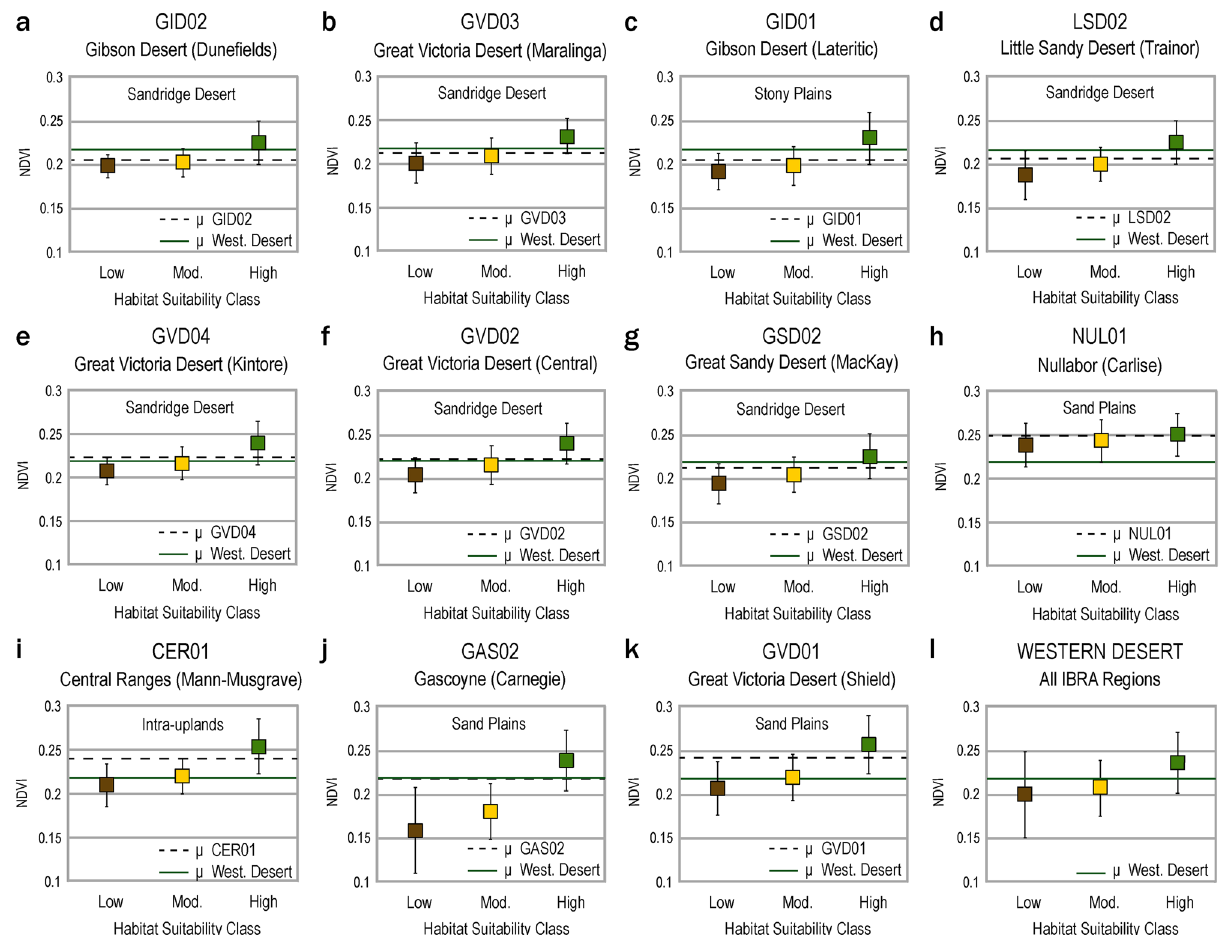
Figure 5. Boxplot of mean NDVI values and one standard deviation for low, moderate, and high-ranked suitability classes for the eleven largest IBRA subregions ( a – k ) of the Western Desert ( l ). Mean NDVI for individual bioregions and the spatial bounds of the Western Desert study area denoted as dashed black line and solid green line, respectively. IBRA subregion boxplot groups ( a – k ) are presented in order of increasing percentage of high-ranked foraging habitat, after Fig. 4. Table S2 offers the precise summarised NDVI values for each bioregion and suitability